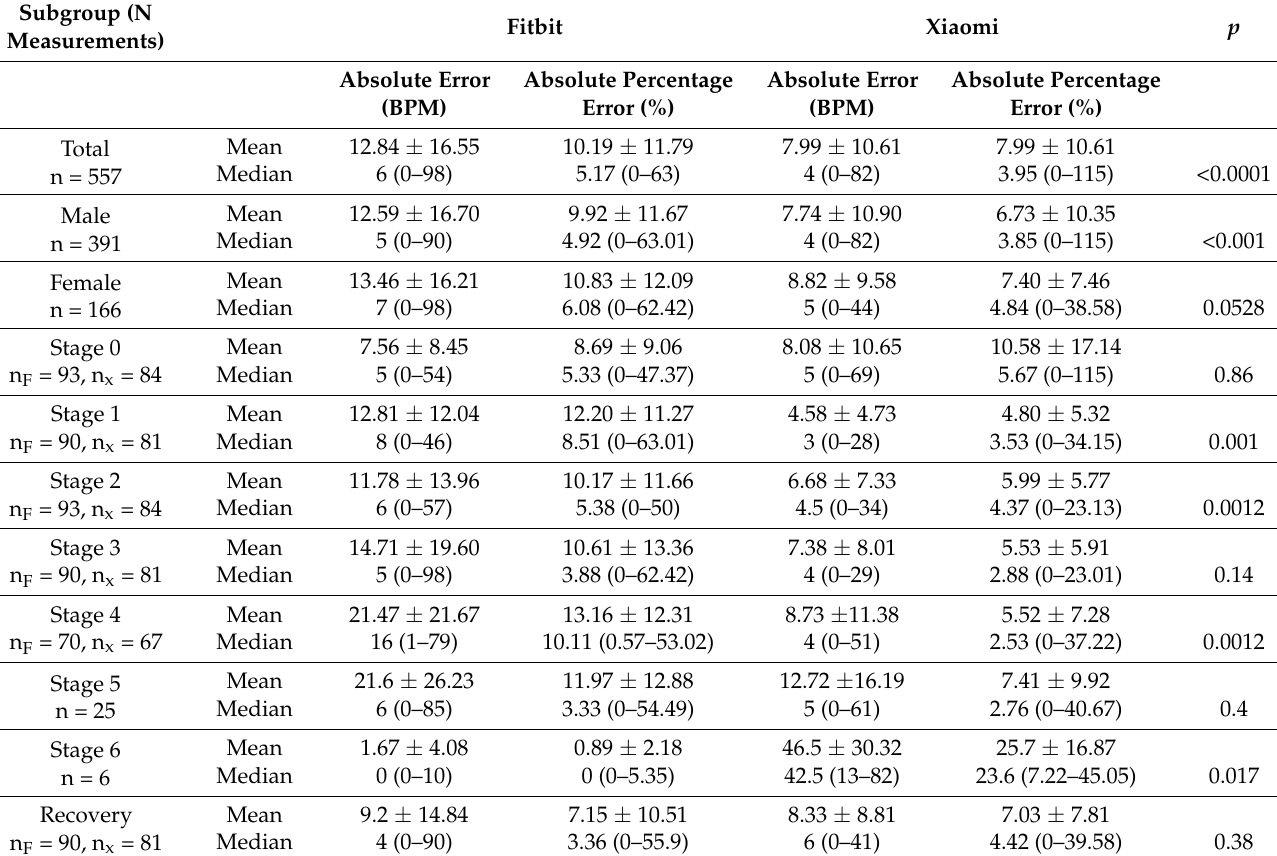
Table 3. Comparison between Fitbit and Xiaomi error